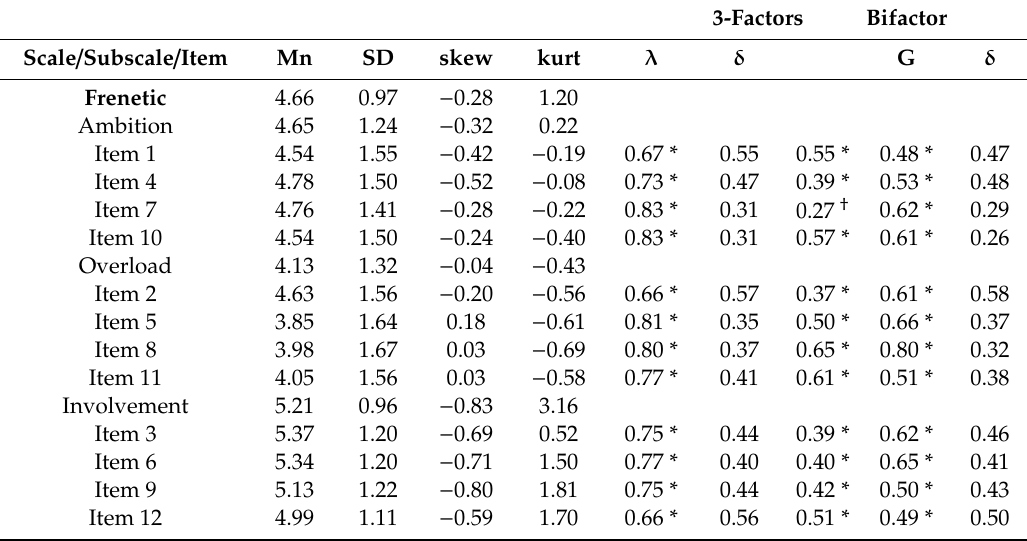
Table 3. Descriptive and psychometric characteristics of the Brazilian